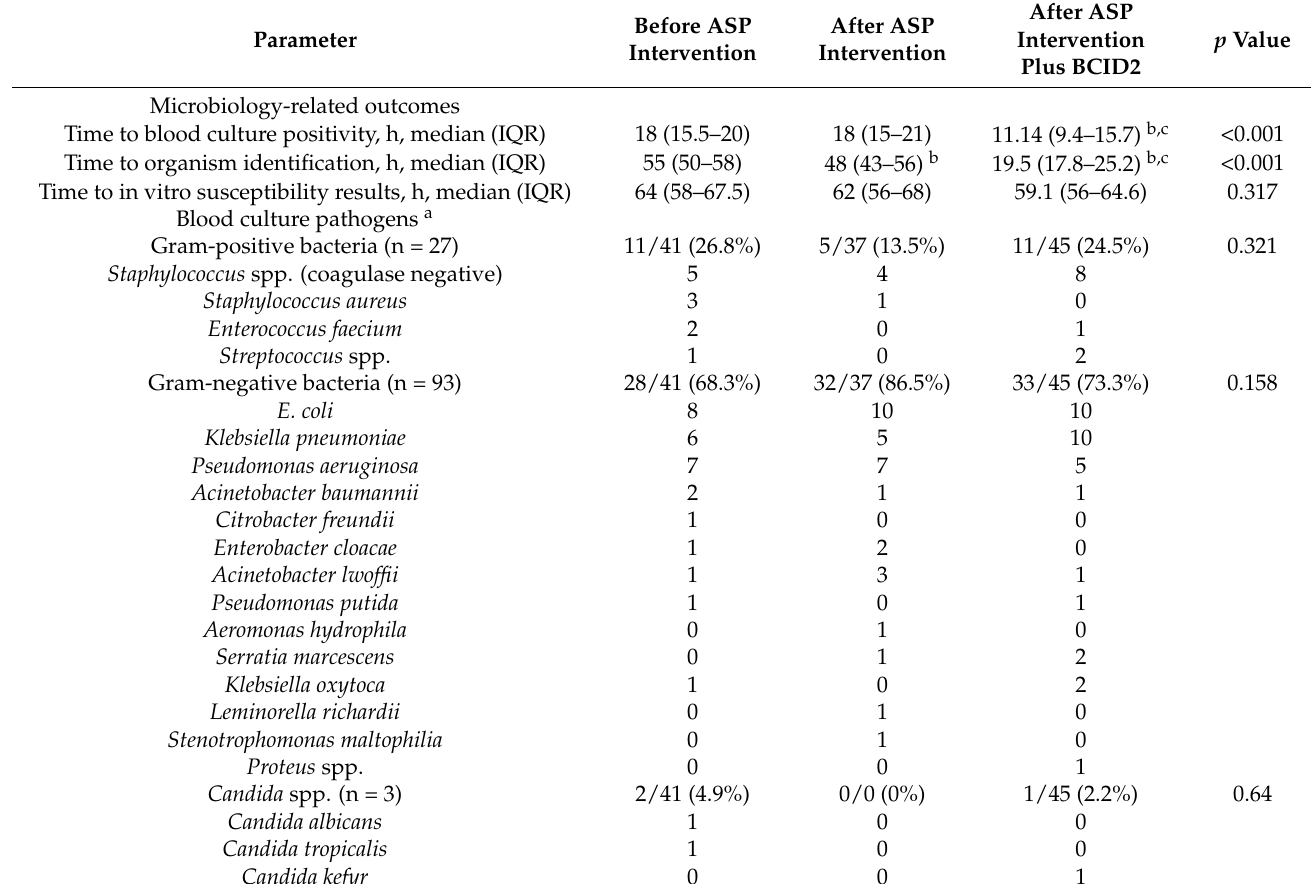
Table 2. A description of blood culture pathogens and microbiology-related outcomes.